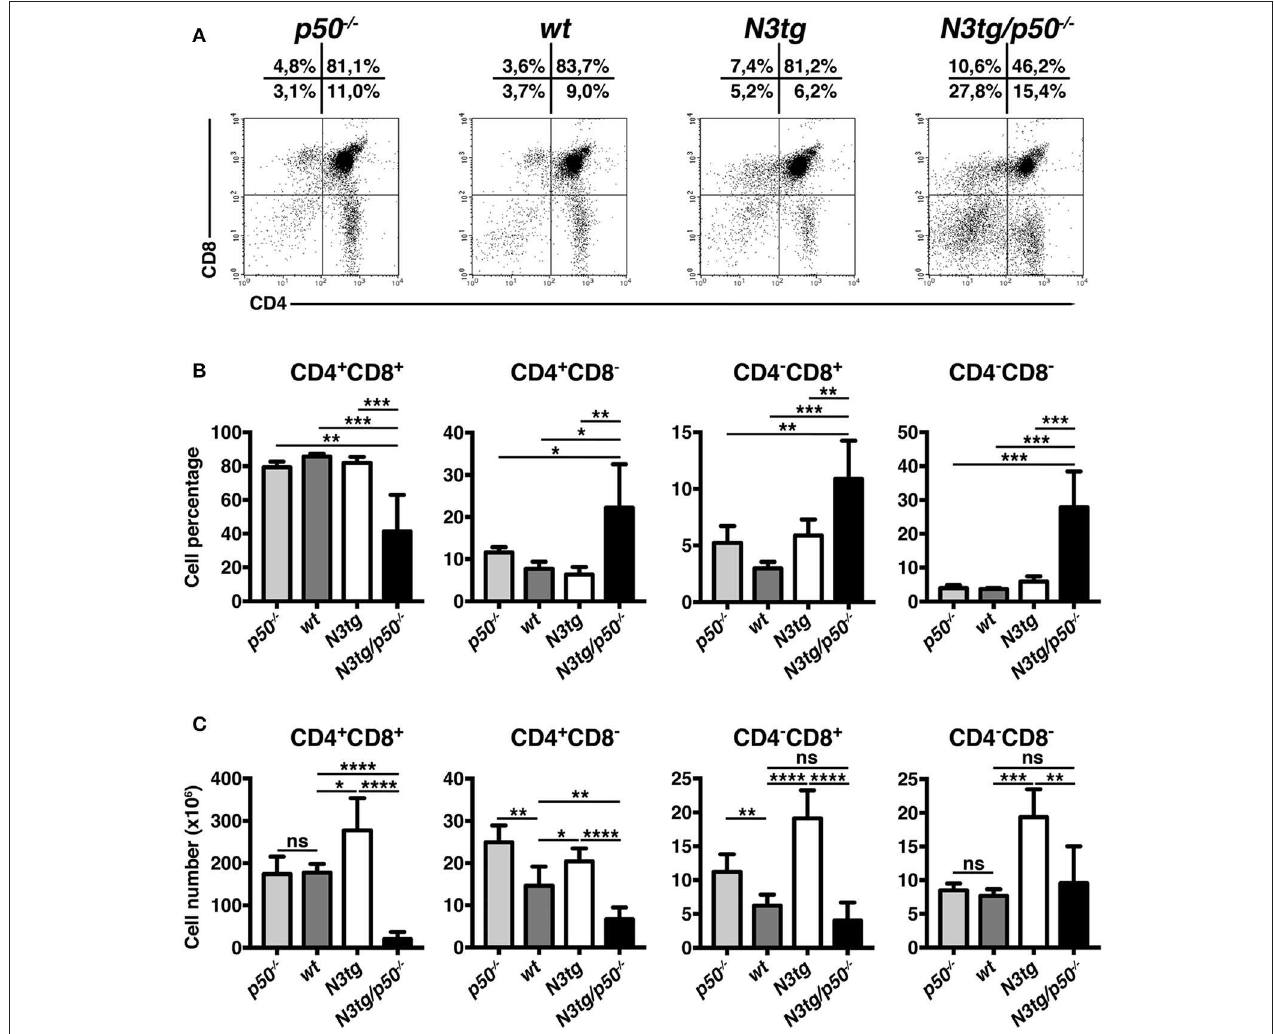
FIGURE 6 | N3tg/p50 − / − mice display altered distributions of thymocyte subsets. (A) Representative dot plots showing CD4 vs. CD8 distributions in the thymus of N3tg/p50 − / − , N3tg , p50 − / − , and wt mice at 4–5 weeks of age, as measured by FACS analysis of CD4 vs. CD8 distributions. Numbers over each cytogram represent the percentages of different T cell subsets. (B) Percentages and (C) absolute numbers of thymocyte subsets in N3tg/p50 − / − , N3tg , p50 − / − , and wt mice, measured as in (A) . In (B,C) the values are presented as mean ± SD of five independent experiments ( n ≥ 5 mice per group). ns, not significant; * P ≤ 0.05, ** P ≤ 0.01, *** P ≤ 0.001, and **** P ≤ 0.0001 represent significant differences between the indicated